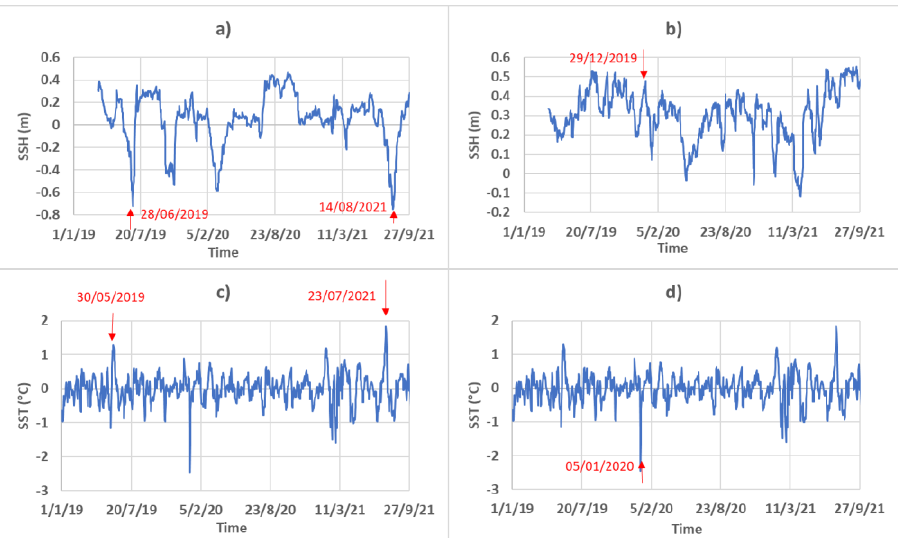
Figure 2. Abrupt events highlighted by SSH at 34.125° N, 148.125° E in ( a ) and at 34.125° N, 140.125° E in ( b ), and by SST averaged along the parallel 34.125° N between 145.625° E and 148.125° E, and filtered in the band of 1 – 68 days to emphasize the rapid variations while attenuating the annual variations. This series is used as the time reference in the wavelet analysis of data. ( a ) and ( c ) are referring to warm events, ( b ) and ( d ) to cold events. SST data is provided by NOAA https://www.ncei.noaa.gov/data/sea-surface-temperature-optimum-interpolation/v2.1/access/avhrr/ (accessed on 27 April 2022). Each SST anomaly corresponds to an opposite SSH anomaly. The reverse is not